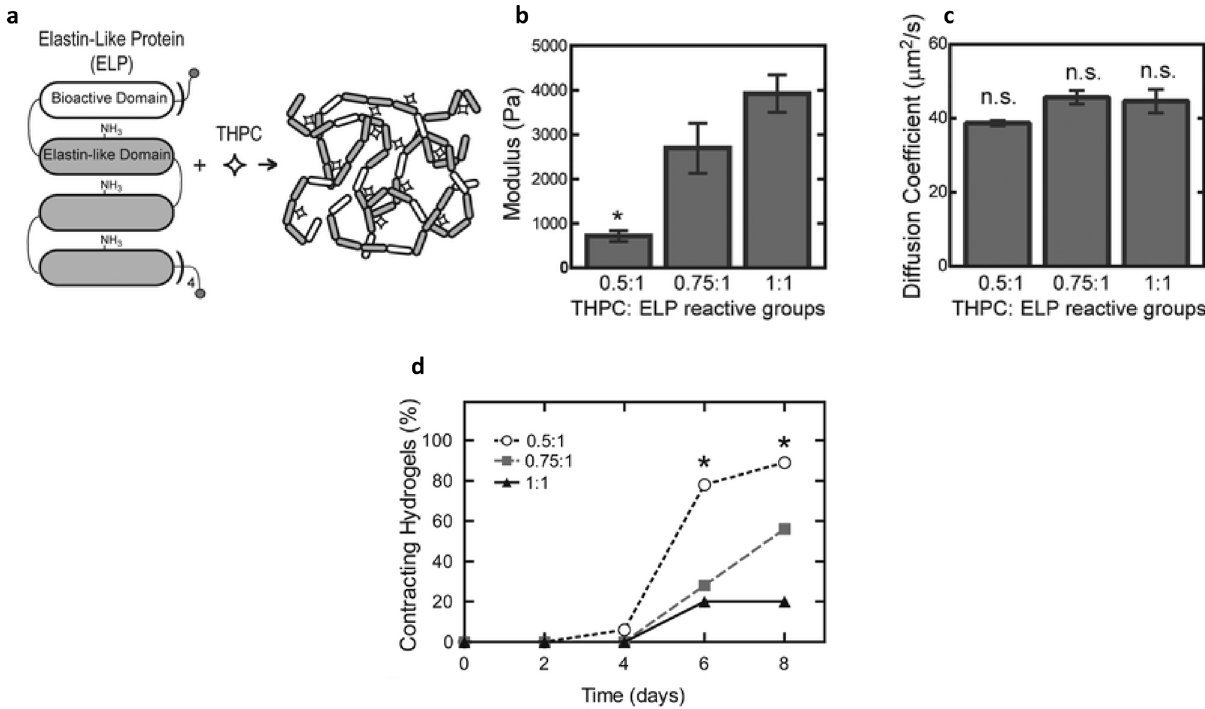
Fig. 5 Growth of cardiomyocytes on recombinant proteins, and effects of elastic modulus on cardiomyocyte differentiation. The elastin-like proteins (ELPs) used by Chung and colleagues ( a ) consist of a bioactive domain translationally fused to one or more elastin-like domains; these domains contain lysine groups to facilitate crosslinking by tetrakis hydroxymethyl phosphonium chloride (THPC). By varying the ratio of THPC to ELP reactive groups, it is possible to tune the elastic modulus of the resulting culture matrix ( b ) without signi fi cantly altering the diffusion of nutrients or other vital factors through the gel ( c ). Embryoid bodies embedded in the matrix undergo differentiation into cardiomyocytes most favorably in the gels with the lowest elastic modulus ( d ); the cells show the greatest contractility when grown in protein crosslinked with a 0.5:1 ratio of THPC:ELP reactive groups. The image is from ref. 190 and is reproduced with